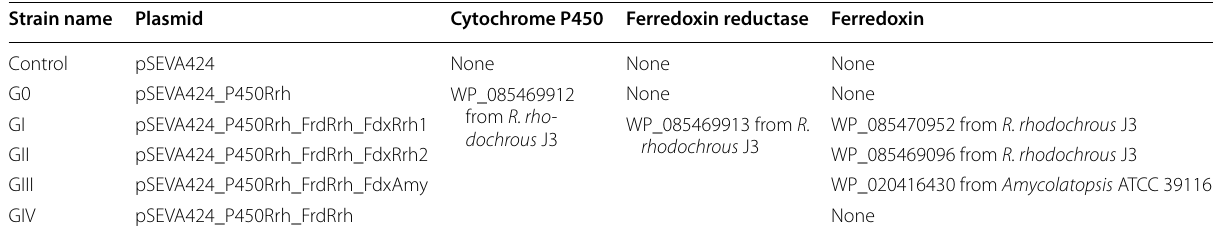
Table 1 P. putida EM42 strains used in this study, their corresponding plasmids and cloned elements thereof Strain name